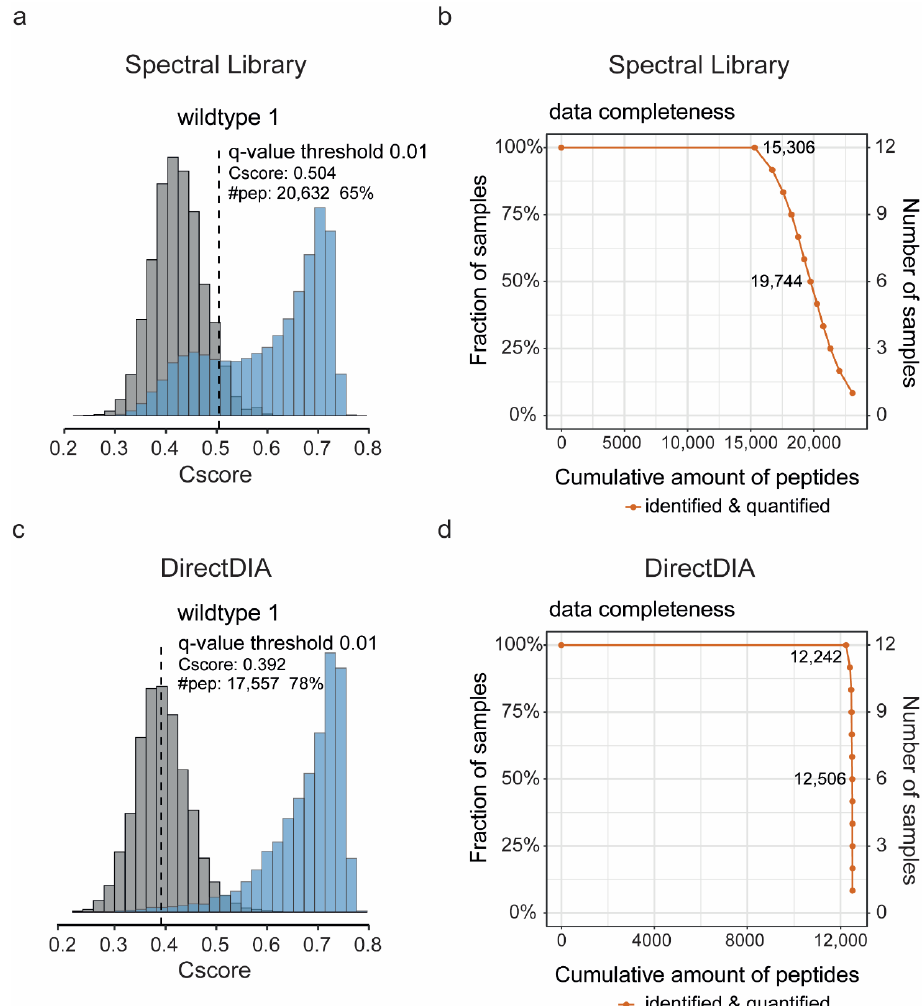
Figure 1. Comparison between the use of a Data Dependent Acquisition (DDA)-based spectral library or directDIA for protein identification and quantification. ( a ) Exemplary histogram of one sample (wildtype 1) showing both target (blue) and decoy (grey) confidence scores (cscores), indicating the level of confidence of peptide identification using the DDA-based spectral library. The q -value confidence threshold of 0.01 is shown as a dotted line, and the associated cscore and number of peptides quantified above this threshold are reported. ( b ) Cumulative distribution showing the number of peptides consistently identified across the range of samples, using the DDA-based spectral library. The exact number of peptides identified are shown at 100% or 50% of samples. ( c ) Analogous to panels a and b: an exemplary histogram of the same sample is shown to visualize target and decoy cscores obtained after identification of peptides in the raw SWATH data using directDIA. ( d ) A cumulative distribution showing the number of peptides consistently identified across the samples, using directDIA. Cscore histograms of all individual samples run against the DDA-based spectral library or directDIA library are reported in Figures S2 and S4, respectively.